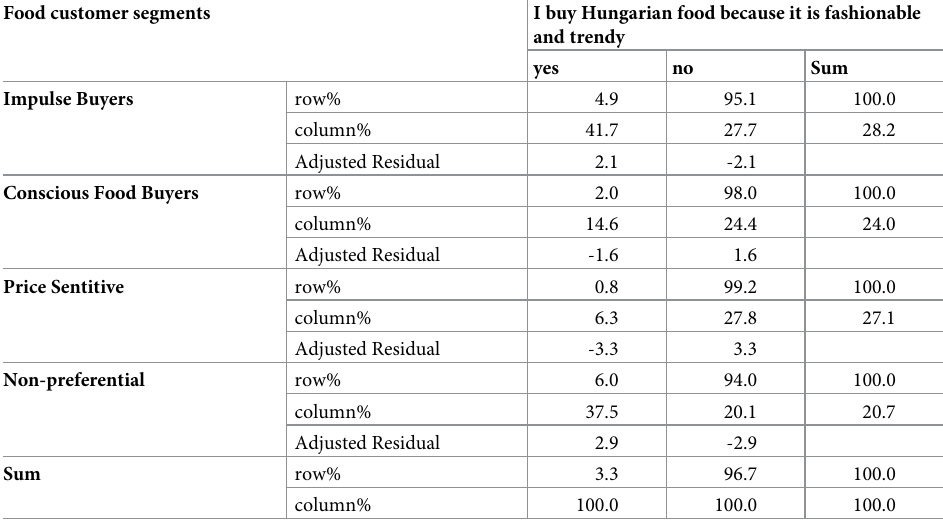
Table 10. Purchasing Hungarian food as a result of fashion and trend among food shopping segments. Food customer